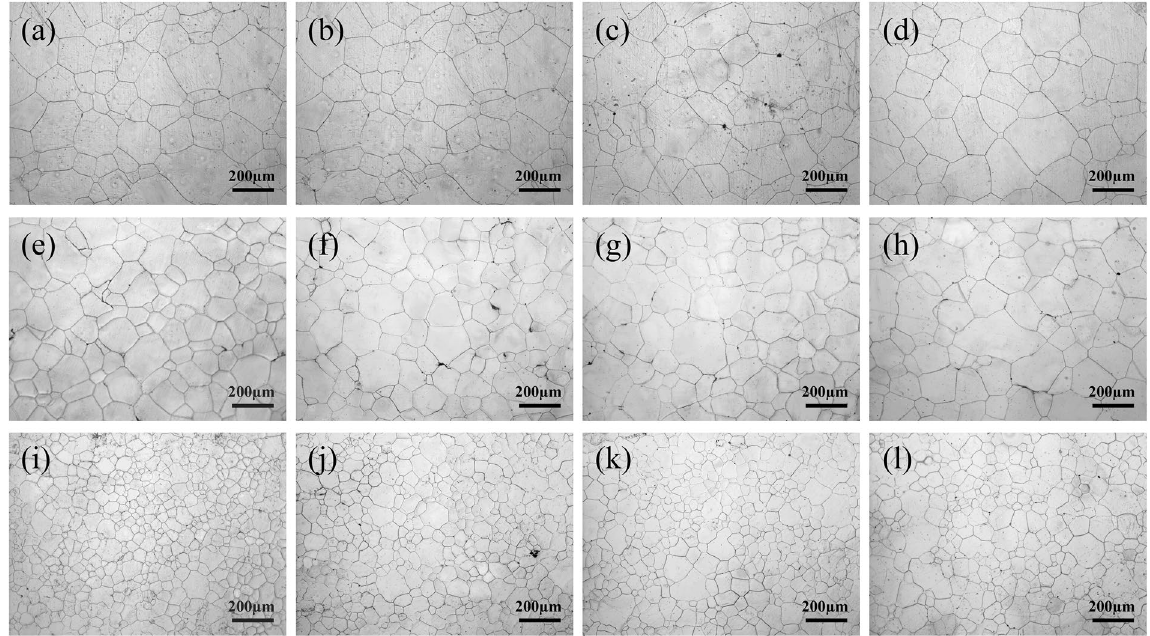
Figure 2. Optical microscopy images of Mg-5Zn alloy microstructures: ( a ) unrolled and subjected to solution treatment at 420 °C for 24 h, ( b ) further aged at 170 °C for 10 h, ( c ) 25 h, and ( d ) 60 h; ( e ) as-rolled (20%) and subjected to solution treatment at 420 °C for 24 h, ( f ) further aged at 170 °C for 10 h, ( g ) 25 h, and ( h ) 60 h; and ( i ) as-rolled (50%) and subjected to solution treatment at 420 °C for 24 h, ( j ) further aged at 170 °C for 10 h, ( k ) 25 h, and ( l ) 60